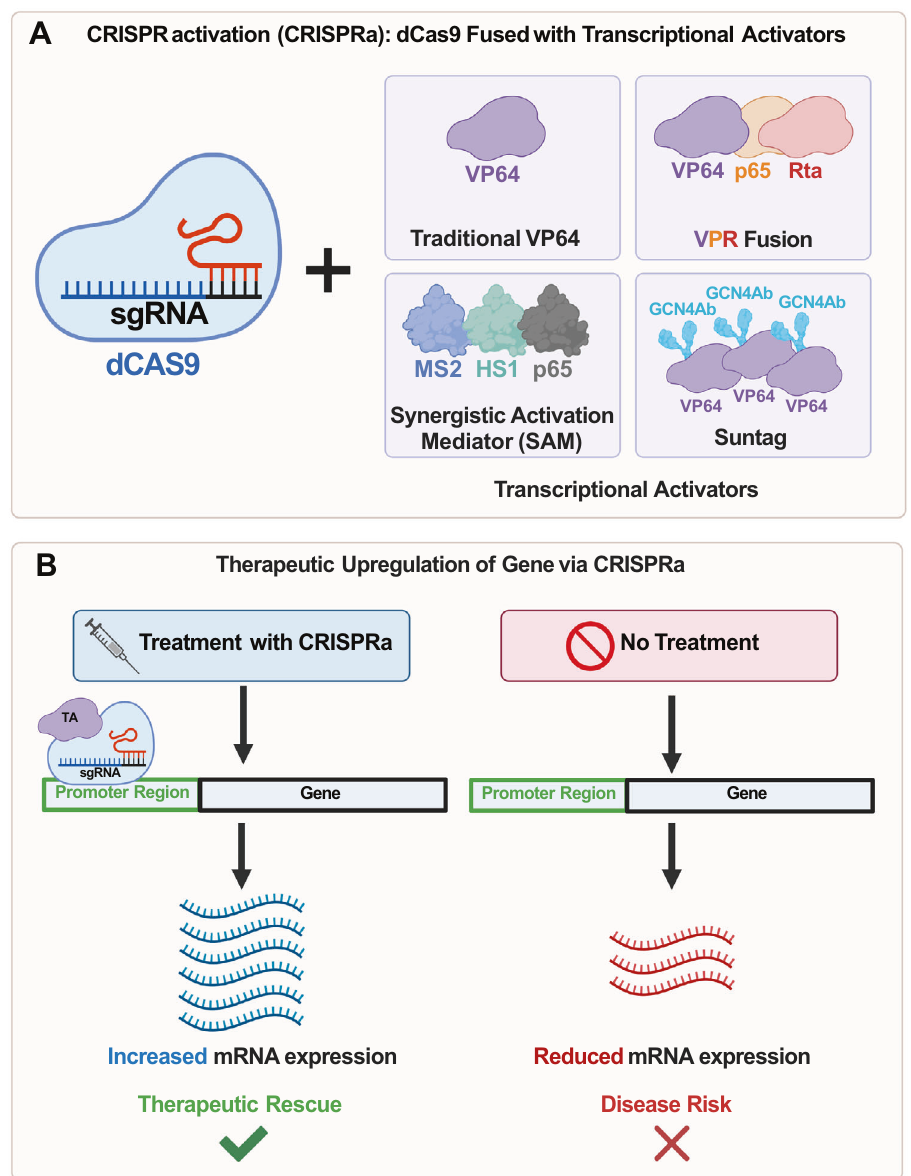
Fig. 2 Schematics of CRISPR activation (CRISPRa) and its ’ role in ASD therapeutics. CRISPRa uses a catalytically dead Cas9 (dCas9) fused with various transcriptional activators. A Depiction of the most common transcription activators (TA) fused to dCas9: (i) The traditional VP64, (ii) A combination of VP64, p65, and Rta (VPR), (iii) The synergistic activation mediator (SAM) system consisting of p65, HSF1, and MS2, and (iv) The Suntag system consisting of dCas9 fused to a polypeptide chain in which a VP64-GCN4 antibody fusion is bound to each peptide — allowing for multiple copies of VP64 to be recruited. B Mechanism of action for CRISPRa. When guided to the promoter region, 1 to 1000 bp upstream of the transcription start site (TSS) of the target gene by a sgRNA construct, the dCas9-VPR will promote an increase in transcription. The reduction in mRNA expression on the right column is a result of the untreated Haploinsuf fi cient gene. Abbreviations : TA Transcriptional Activator, Rta Epstein-Barr Virus R Transactivator, MS2 - Bacteriophage Coat Protein, HSF1 Human Heat-Shock Factor 1, GCN4Ab GCN4